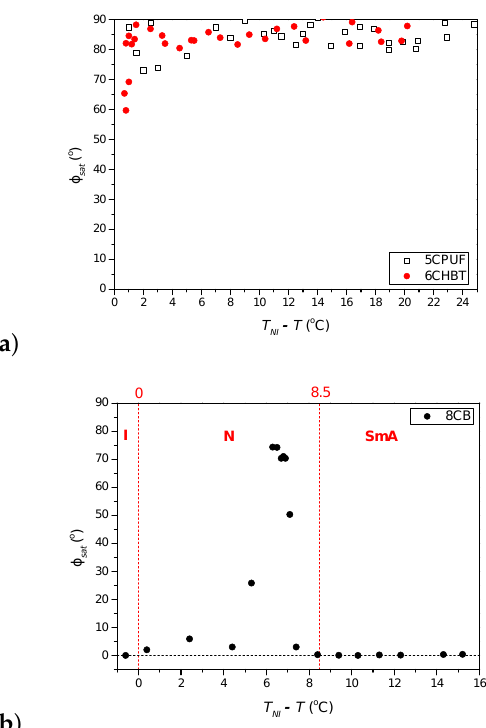
Figure 3. Temperature dependence of the saturated azimuthal photoalignment angle ϕ sat measured for ( a ) 5CPUF and 6CHBT, and ( b ) 8CB liquid crystals (I, N and SmA indicate the temperature range of isotropic, nematic and smectic A phase, respectively).